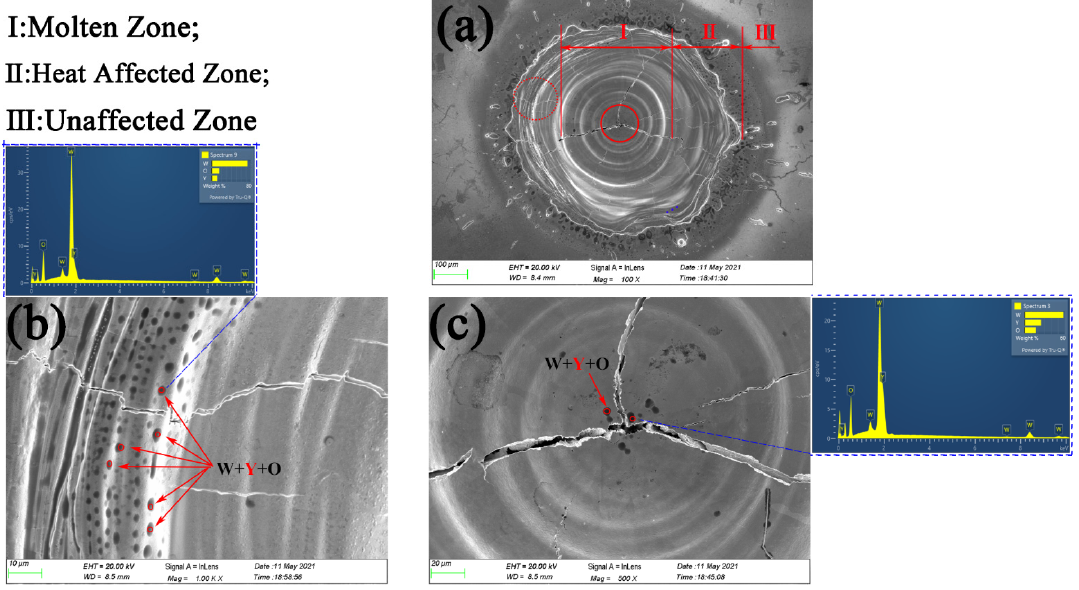
Figure 10. SEM images of the fully recrystallized sample at 0.64 GW/m 2 : ( a ) the heat loading zone; ( b ) the HAZ; ( c ) the molten zone.